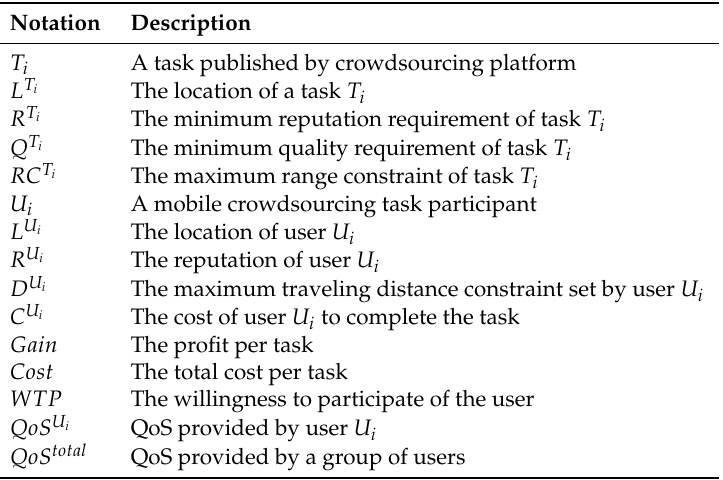
Table 2. Main notations used throughout the